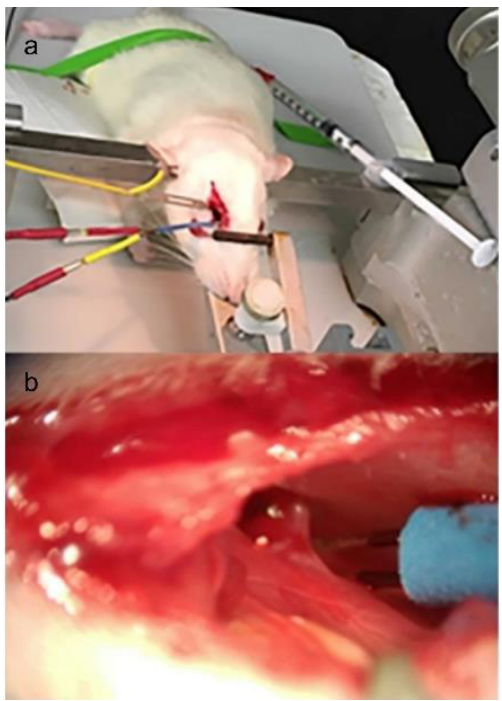
Figure 1. ( a ) An example of a rat with the bipolar electrode in place as well as an intra-arterial (Internal Carotid Artery) catheter with a syringe and a close up of ( b ) the anterior ethmoidal nerve with the hook electrode.